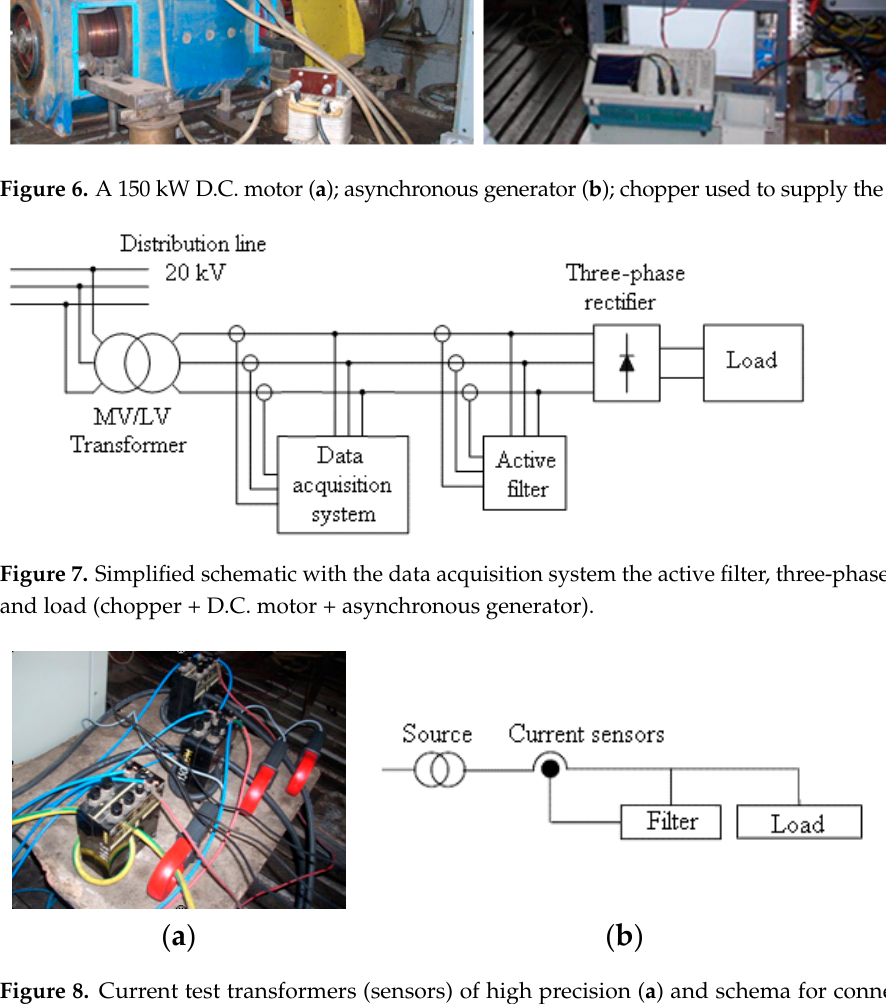
Figure 8. Current test transformers (sensors) of high precision ( a ) and schema for connecting the current test transformers for the filter ( b ).